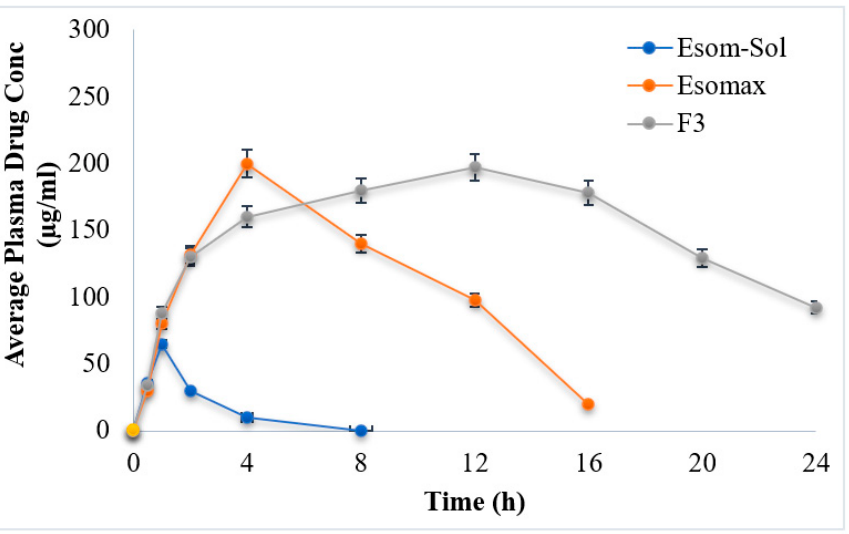
Figure 6. In vivo profile of esomeprazole.